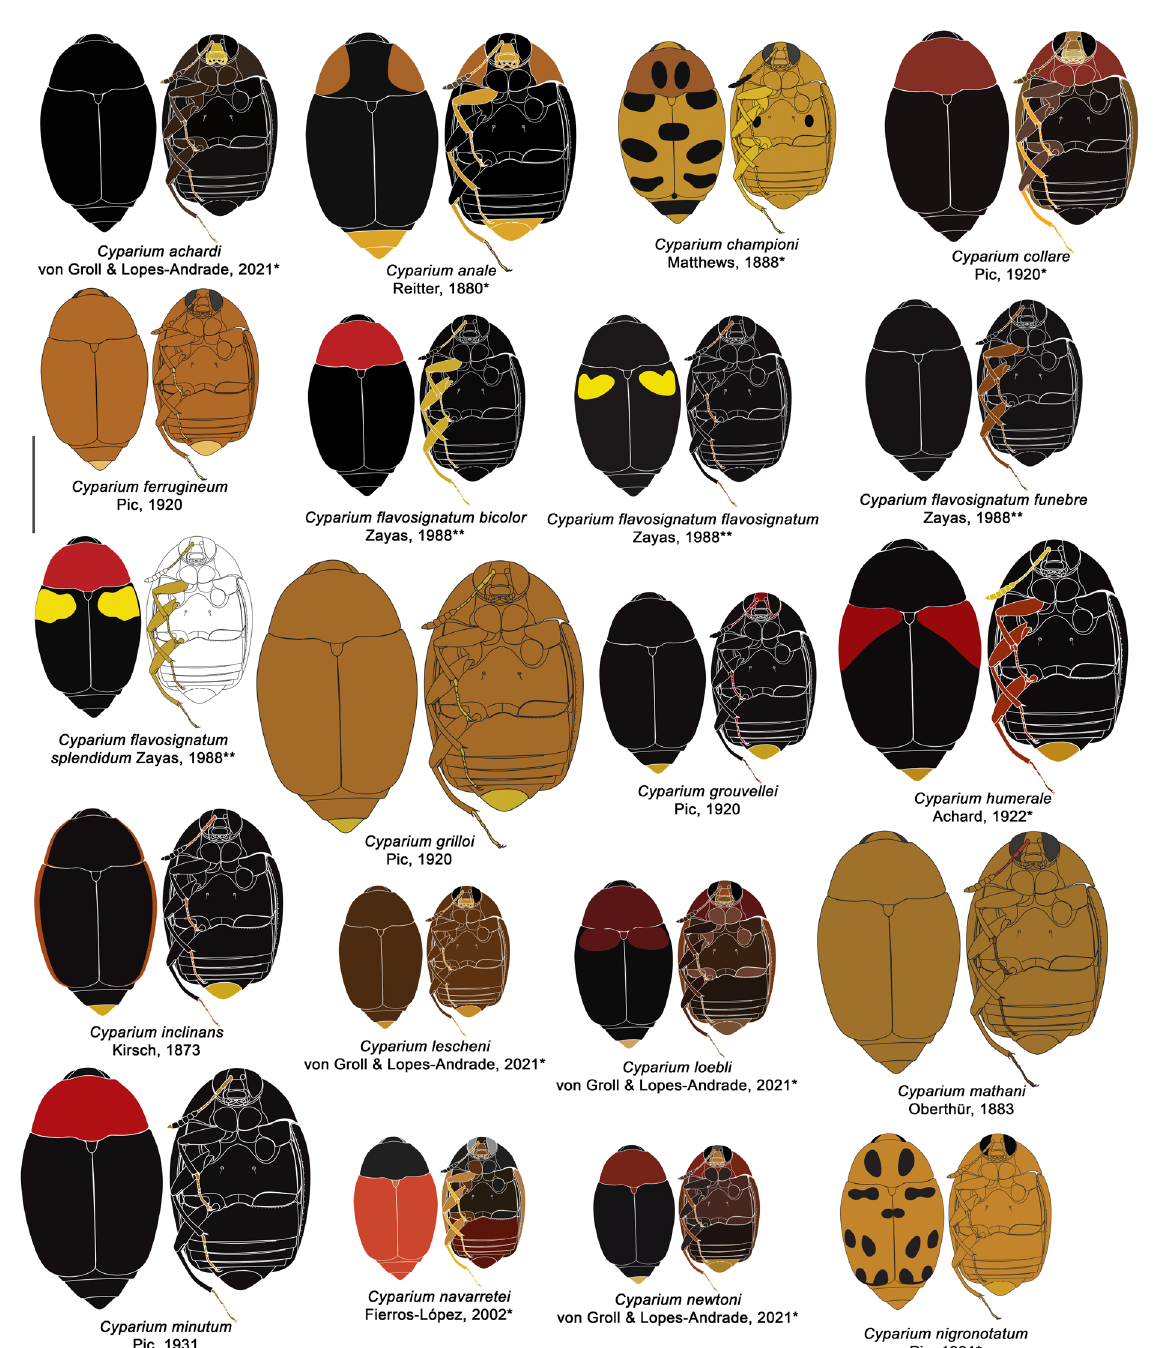
Fig. 4. Cyparium Erichson, 1845 . Neotropical species. Illustrations based on the original descriptions. *Illustrations made based on photographs, specimens, or illustrations made by other authors; **size not provided in original description. Model: Cyparium collare Pic, 1920. Scale bar = 2